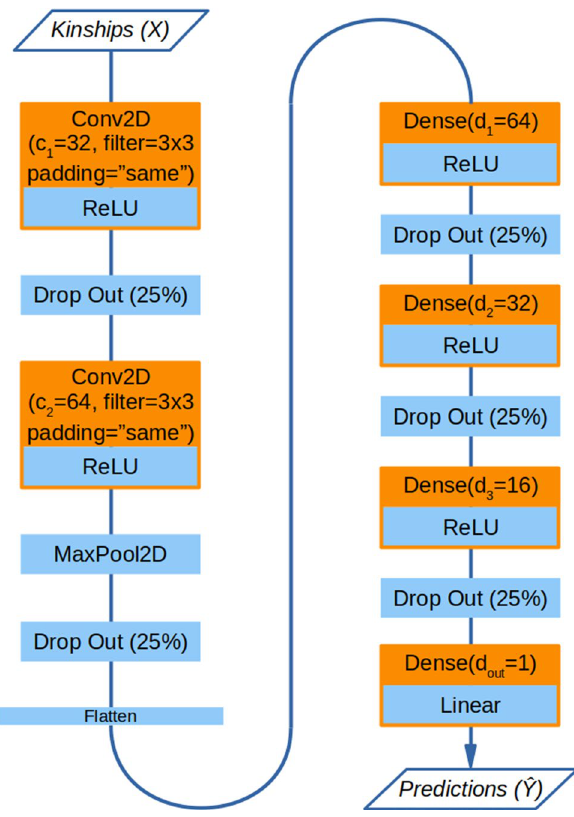
Figure 4. Final deep learning architecture selected after hyperparameter tuning. Trainable layers are represented in orange. All layers with the exception of the last one use the ReLU activation function. The last layer always has a single node ( d out = 1 ) and uses a linear activation function so to produce a continuous output